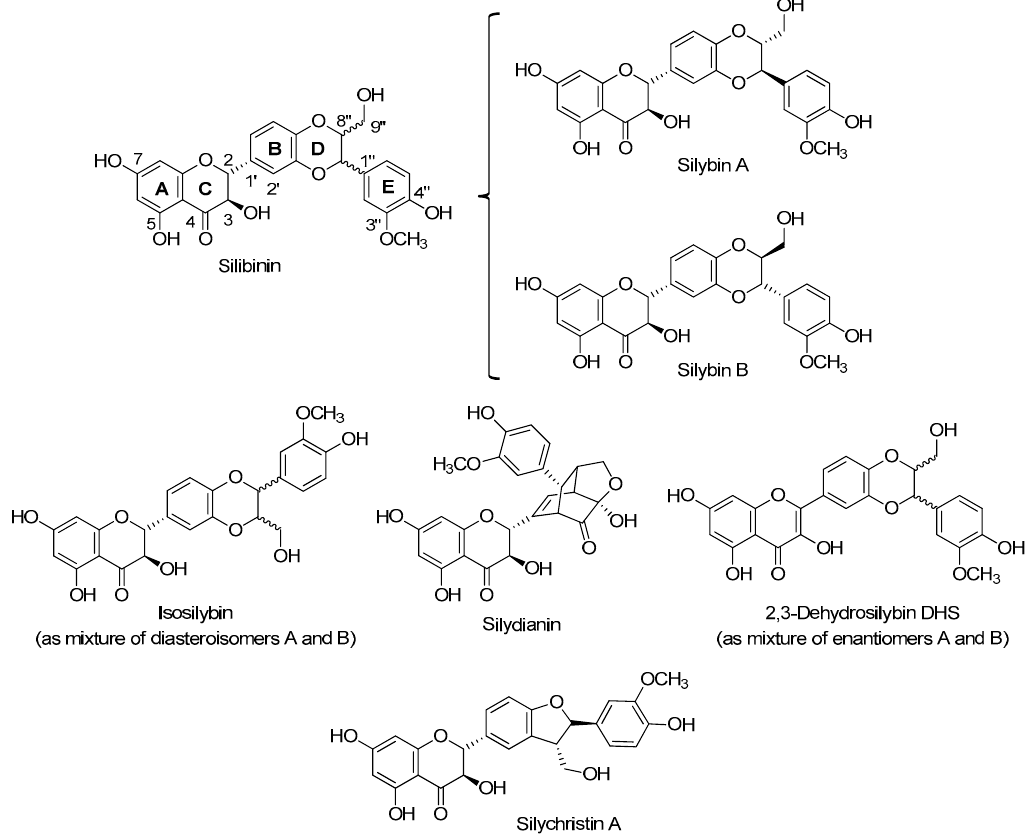
Figure 2. Main flavonolignans from S. marianum (L. Gaertn. (Asteraceae)).